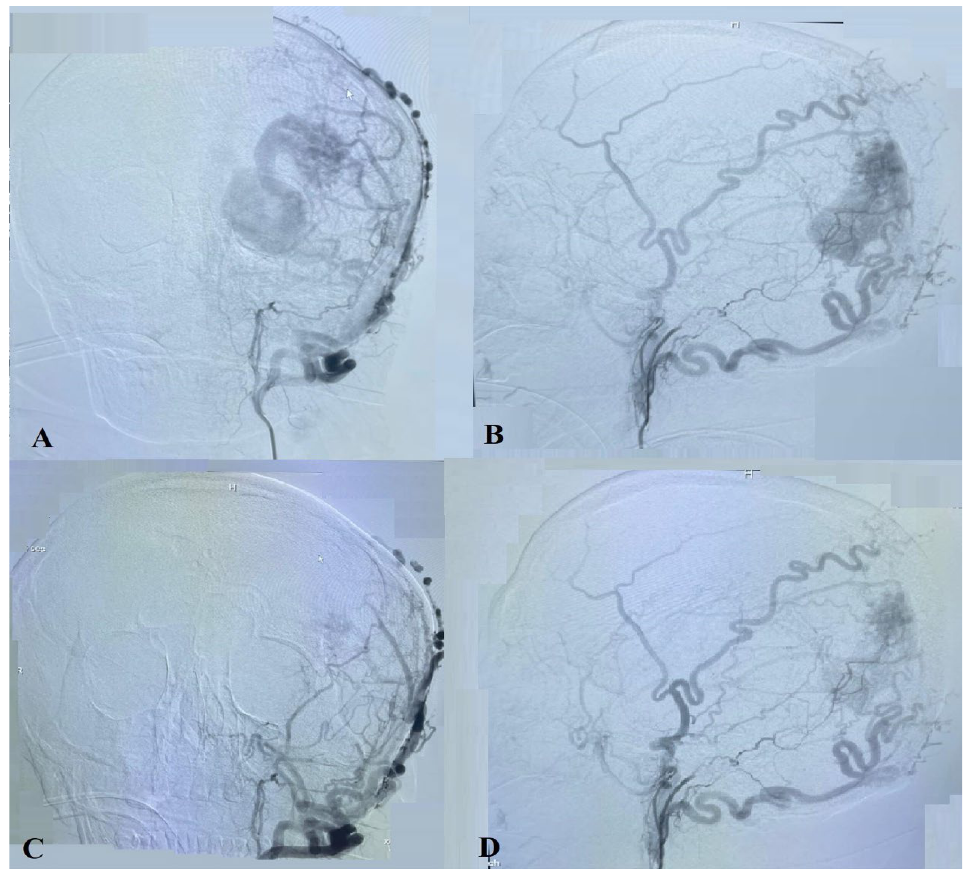
Figure 3. A carotid angiogram from left ICA ( A – D ) shows a left occipital AVM fed by many small arteries (left occipital, left superficial temporal, and left middle meningeal arteries).